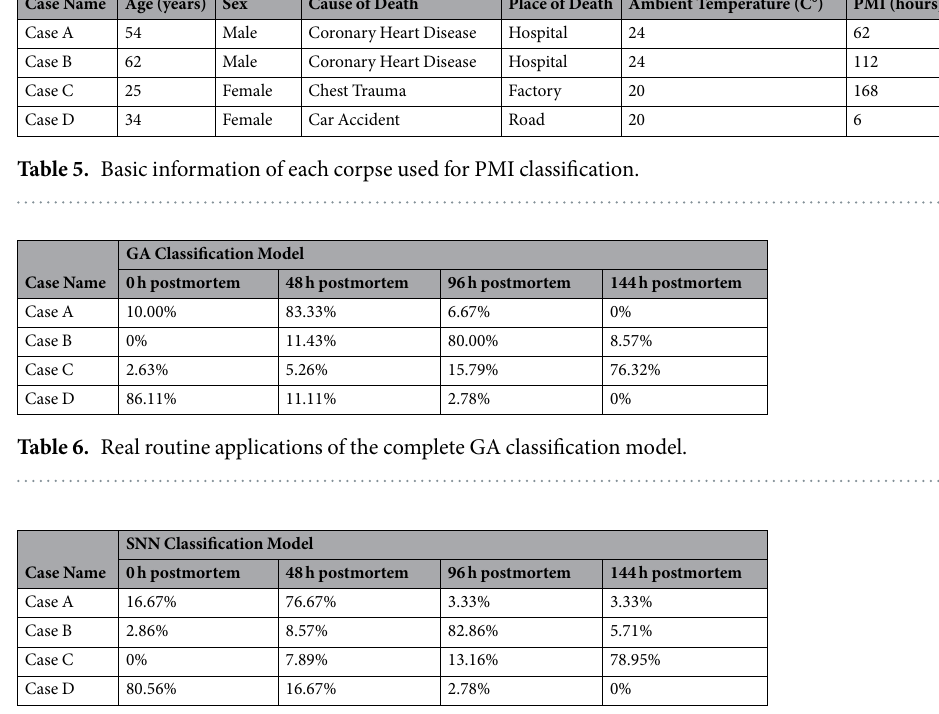
Table 7. Real routine applications of the complete SNN classification model.